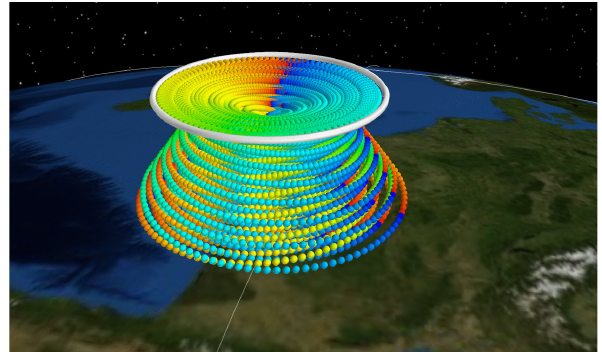
Fig. 4. A circular flight path including the location of the tangent points of the measurements as color-coded spheres (red being the first measurements, blue the last ones) and the flight-track as a white